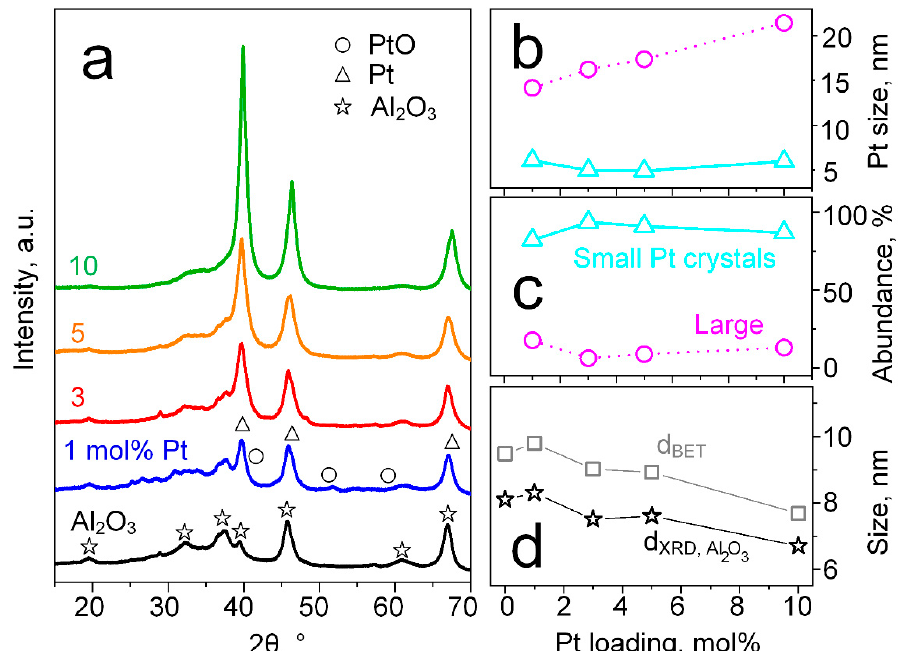
Figure 1. ( a ) XRD patterns of as-prepared pure (black), 1 (blue), 3 (red), 5 (orange) and 10 mol% (green) Pt/Al 2 O 3 particles with reference peaks for cubic Al 2 O 3 (stars), Pt (triangles) and PtO (circles). Note that all spectra were normalized to the Al 2 O 3 peak at 2 θ = 67.1°, that is less affected by Pt content. ( b ) Average crystallite size and ( c ) relative abundance of small (triangles) and larger (circles) Pt crystals, respectively, as a function of Pt content. Bimodal Pt crystal sizes were calculated using the Scherrer Equation after deconvolution of the Pt peak at 2 θ = 39.7° (Figure S1). The abundance was determined from the respective peak areas. ( d ) Pt/Al 2 O 3 particles size (BET-equivalent, squares) as determined by N 2 adsorption and Al 2 O 3 crystal size (stars) as calculated with the Scherrer Equation at 2 θ = 67.1° as a function of Pt content.